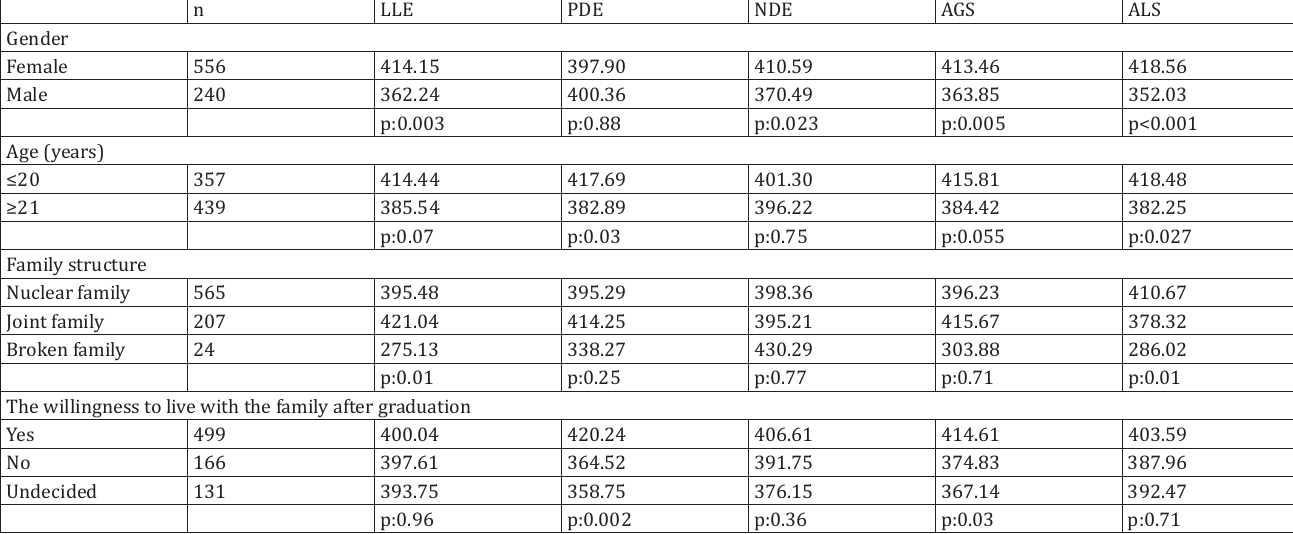
Comparison of AGS and ALS scales according to socio-demographic characteristics (n=796).